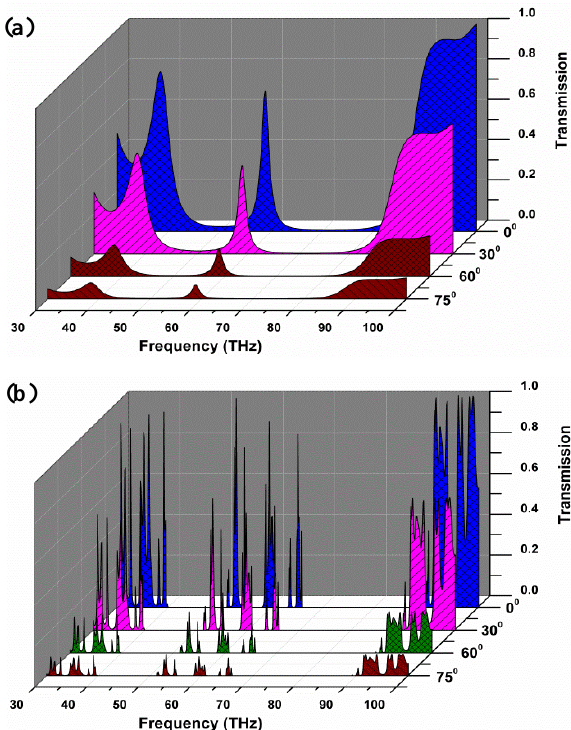
Figure 8: TE Transmittance spectrum of SbSBr based Fibonacci Photonic crystal structures of (a) 5th and (b) 10th generations from 0° to